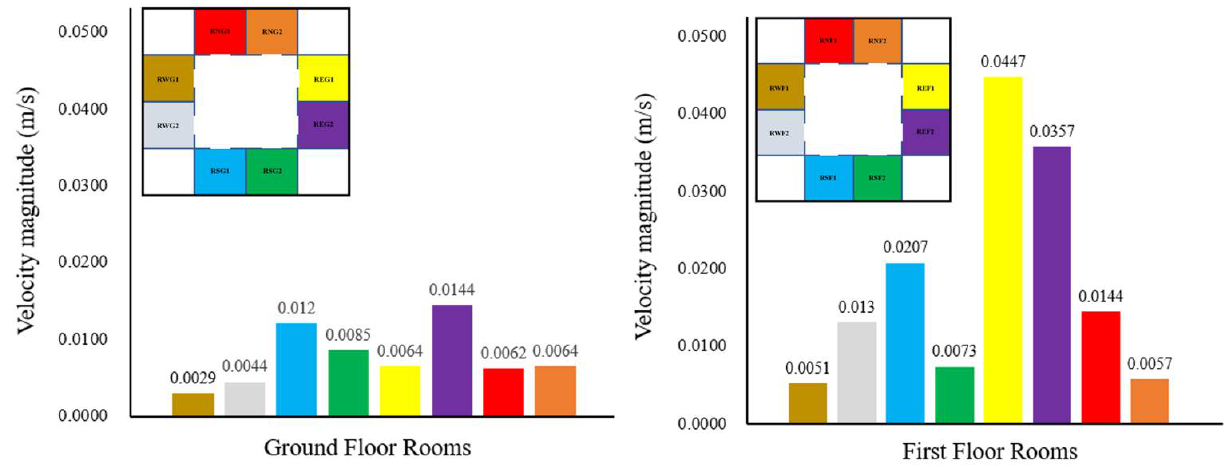
Figure 15. Average wind speed magnitude (m/s) in each room for the baseline courtyard model.